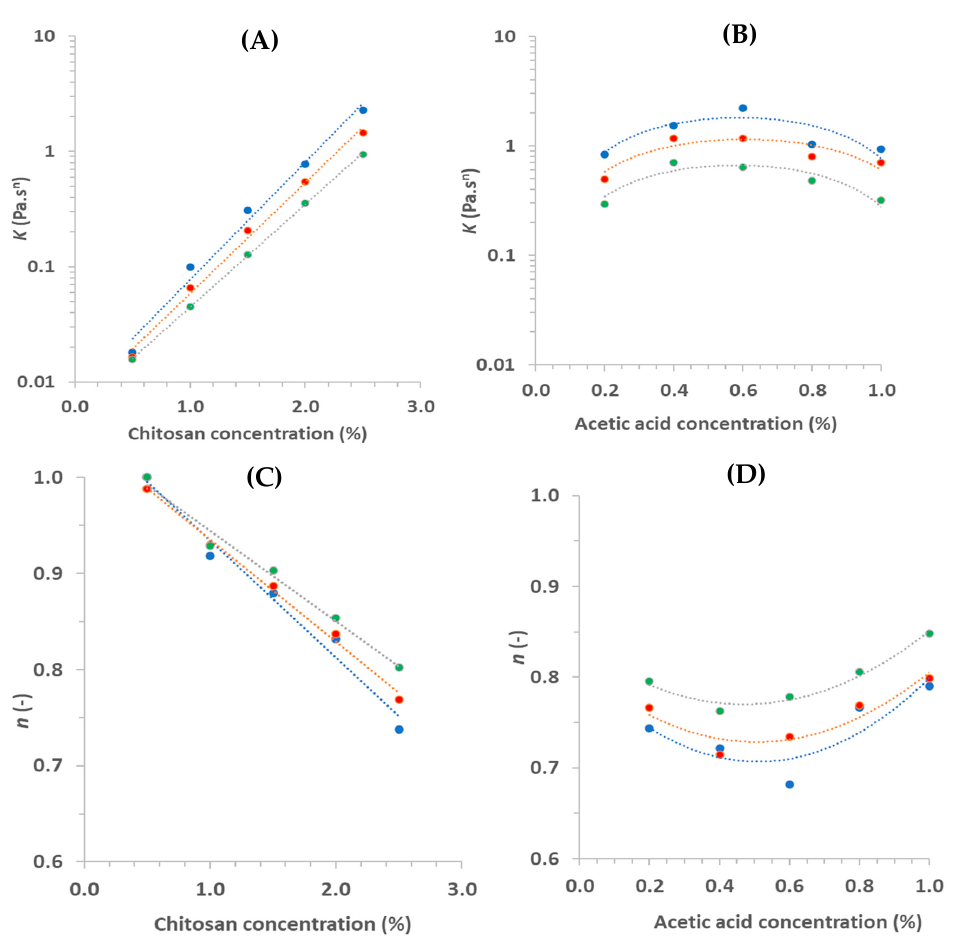
Figure 5. Consistency index ( K ) and index flow behavior ( n ) as a function of the chitosan concentration ( A , C ) and of the acetic acid ( B , D ), at 25 (blue), 35 (red), and 45 °C (green).